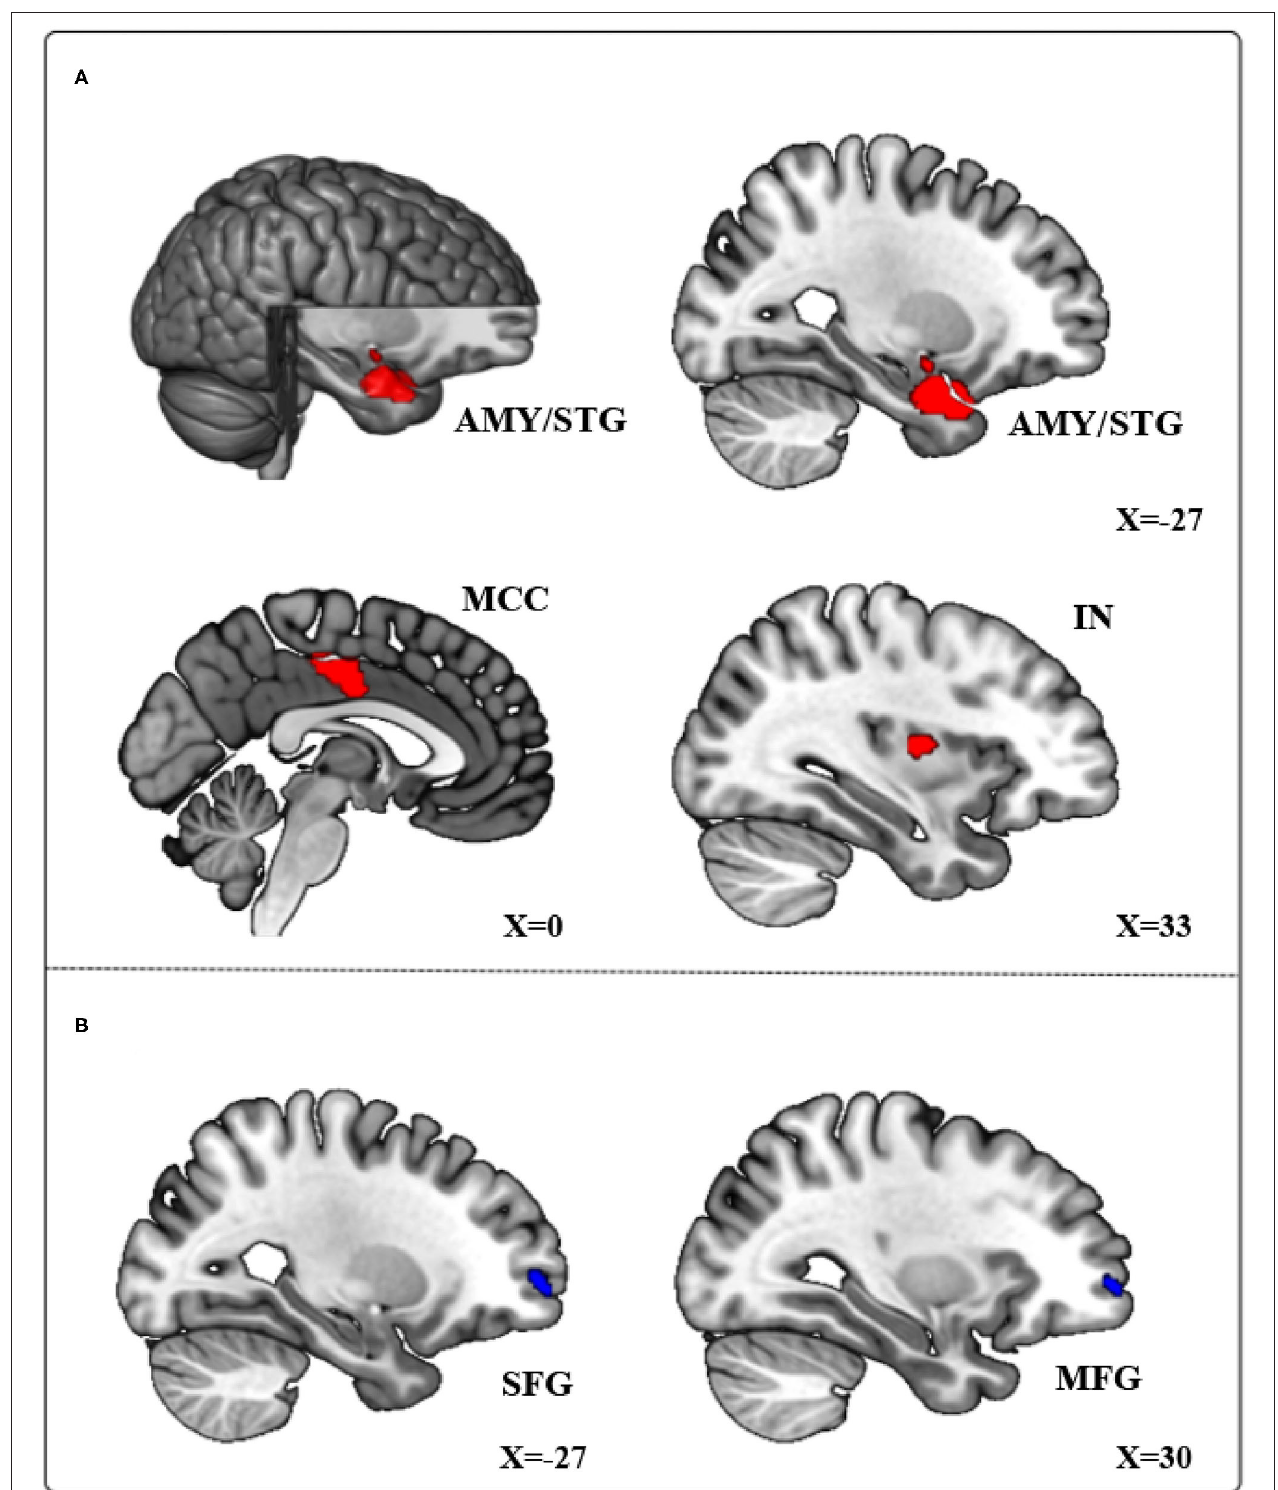
FIGURE 2 | Meta-analytical results of the contrast of Pathological Internet Use (PIU) vs. healthy controls (HC). (A) Red regions showing significant increases in the left temporal pole of the STG (STGtp), left amygdala (AMY), bilateral median cingulate cortex (MCC), and right insula (IN). (B) Blue regions showing significant decreases in the left dorsolateral SFG (SFGdl) and right middle frontal gyrus (MFG).